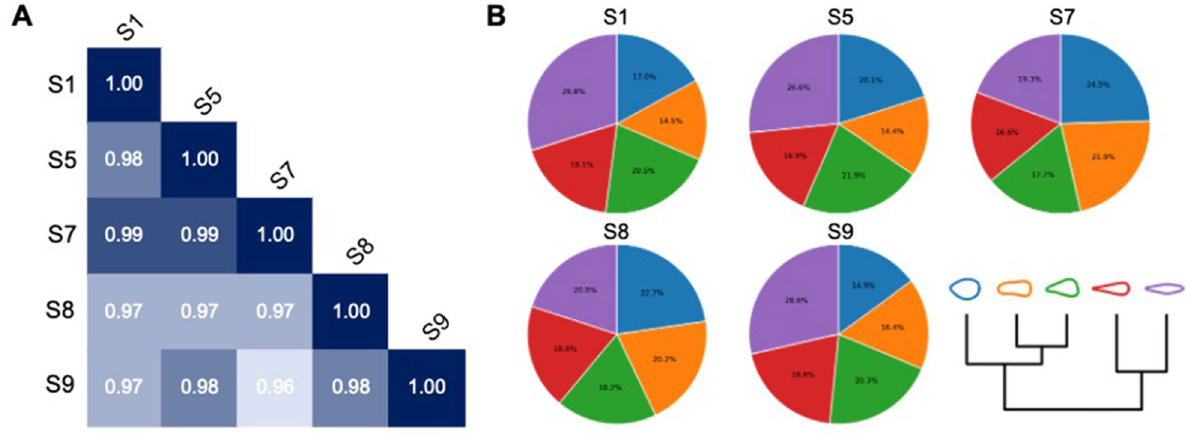
Figure 2. ( A ) Pearson correlation values of hNTSCs from different donors. ( B ) Morphological distribution of hNTSCs from each